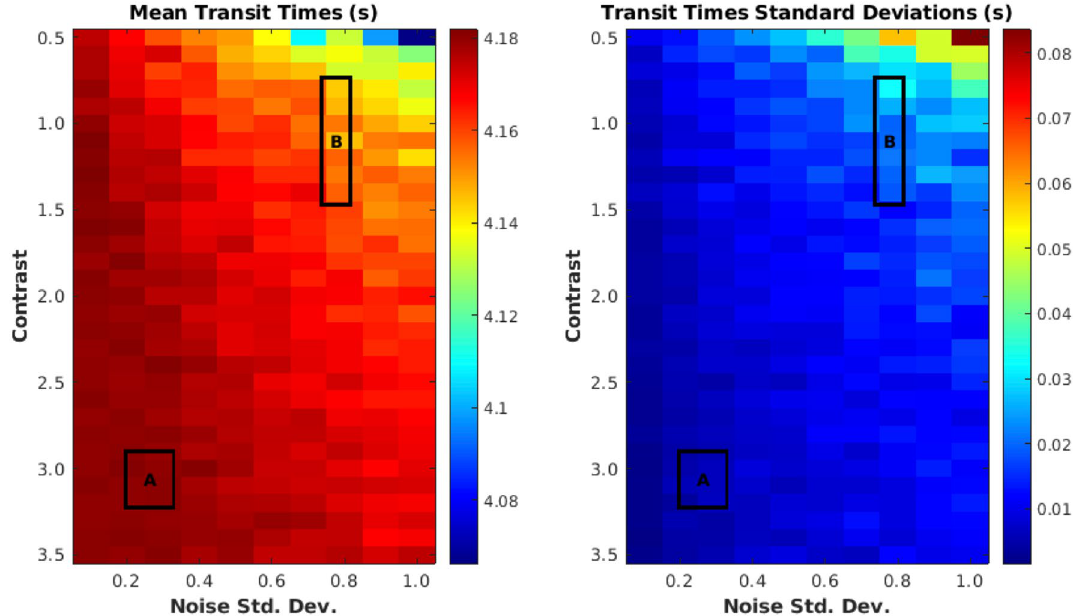
Figure 7. Slope-detection algorithm performance at varying signal contrast and noise levels, given in units of signal intensity resulting after scaling/demeaning of BOLD signals. Contrast reflects the difference between peaks and valleys in the global BOLD signal, while noise level reflects an estimation of the standard deviation of noise assuming a model of additive Gaussian noise. A DSC SHAG carpet plot was scaled to varying contrasts and noise levels (see Supplementary Material Sect. 6) and the transit time of the gadolinium-arrival edge was computed. 30 random white noise trials were conducted at each contrast/noise level pair. Boxes labeled A and B show the regions of contrast and noise level covered by actual DSC-MRI and rs-fMRI SHAG carpet plots,